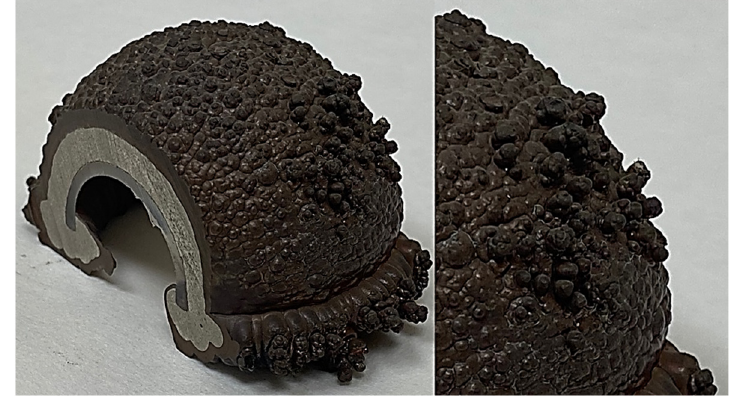
Figure 2. Nodular growth defects.